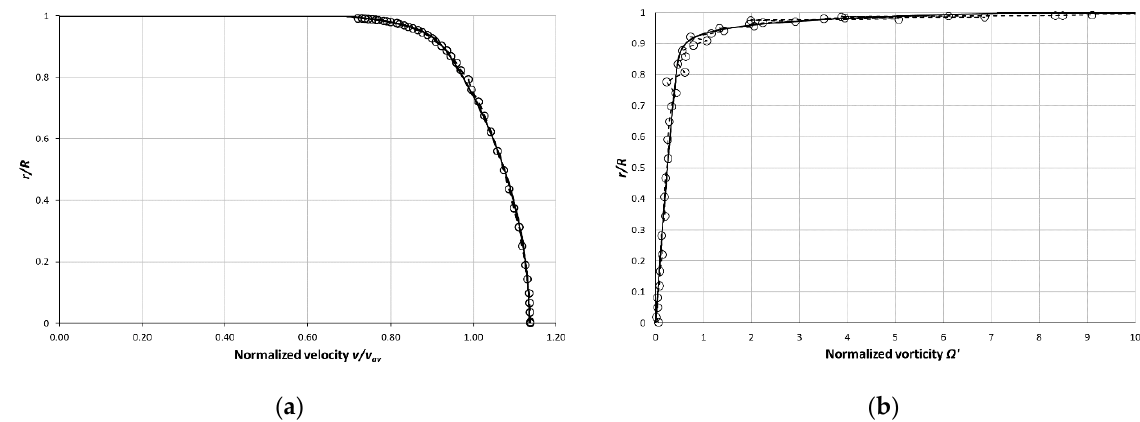
Figure 22. The experimental data (PSP) for Re = 31,577 comparison with predicted mean velocity profile. The average velocity and Re are known in this case. All other parameters are evaluated from the empirical expressions. Dashed line with circles represents the experimental data, the solid line is the analytical profile. ( a ) Normalized mean velocity profile, ( b ) Normalized vorticity distribution.